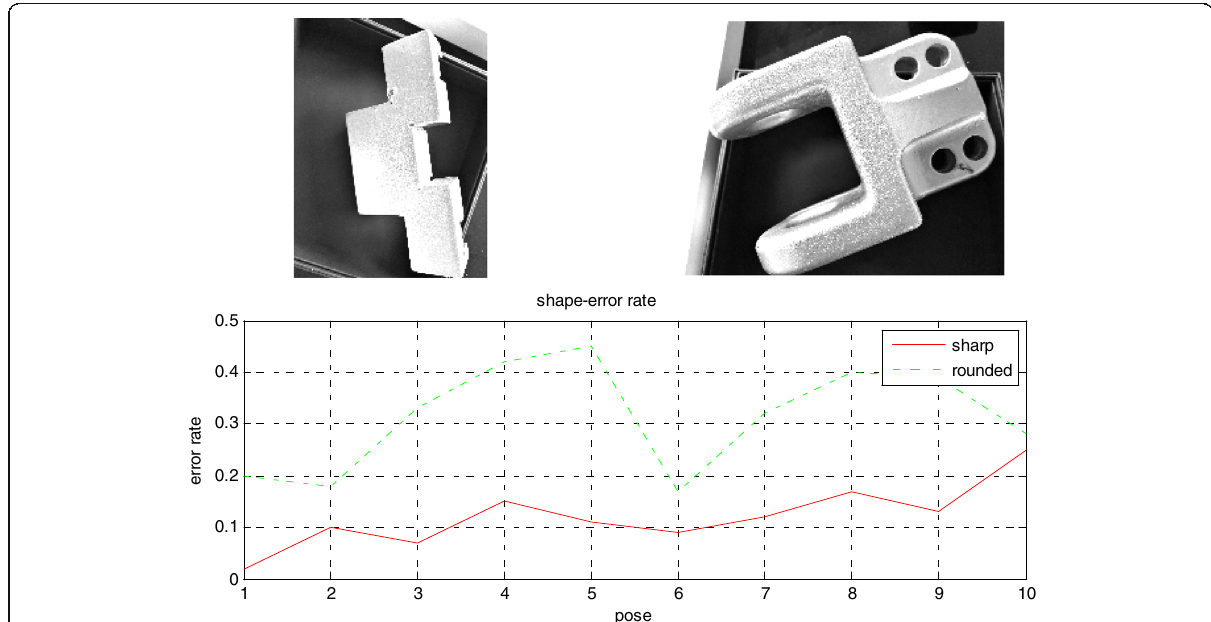
Fig. 7 Error rates about rounded and sharp